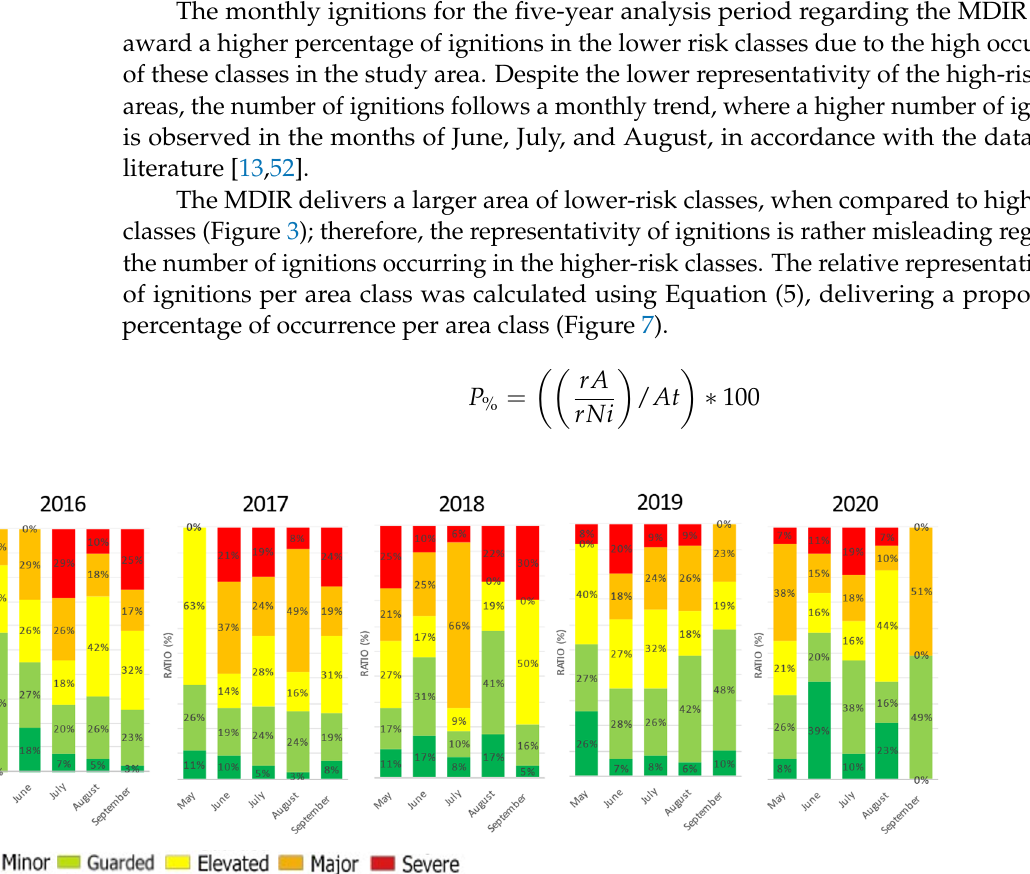
Theorem 5. The representative percentage of ignitions per associated representative area (P%) equals the relative area of each risk class (rA) divided by the relative number of ignitions in each class (rNi), divided by the total area of classes (At), and multiplied by